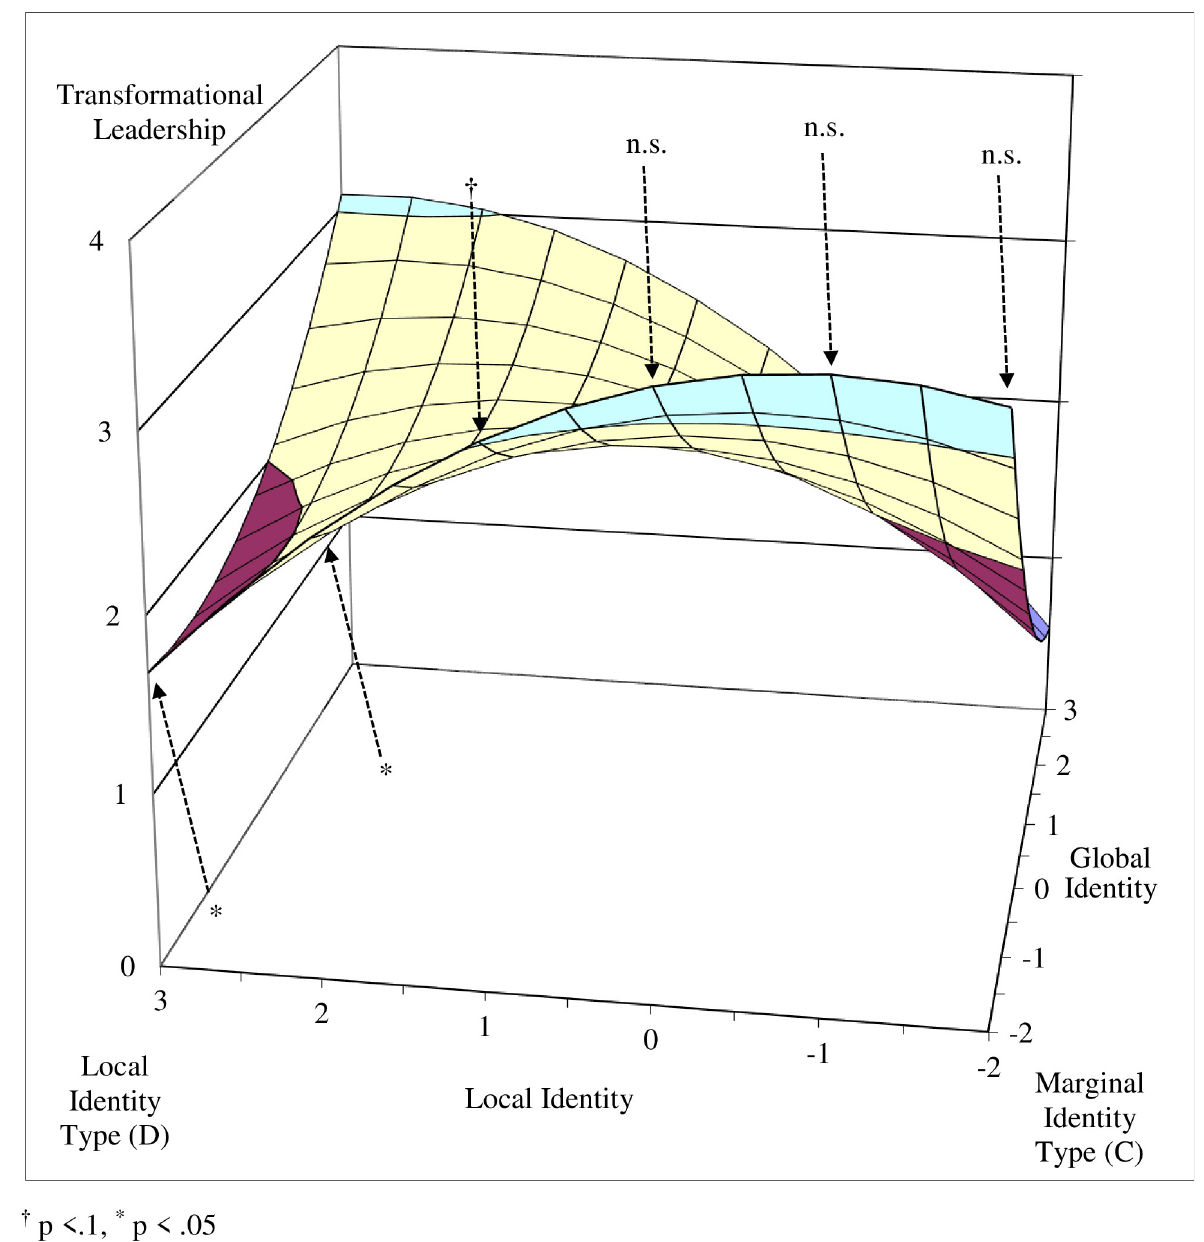
Fig 5. Tangent slope significance along the local–marginal line as predictor of transformational